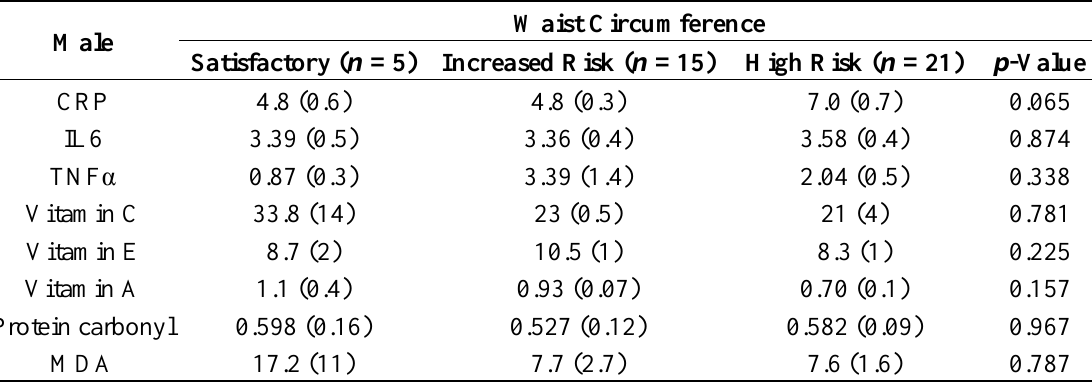
Table 4. Antioxidants and markers of oxidative damage and inflammation according to the WHO waist circumference cut-off-points for male subjects (mean SE).